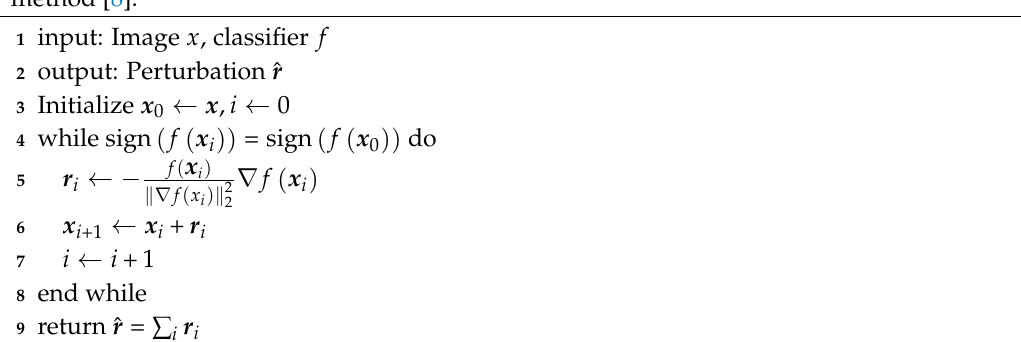
Algorithm 1: The process of generating adversarial examples based on DeepFool method